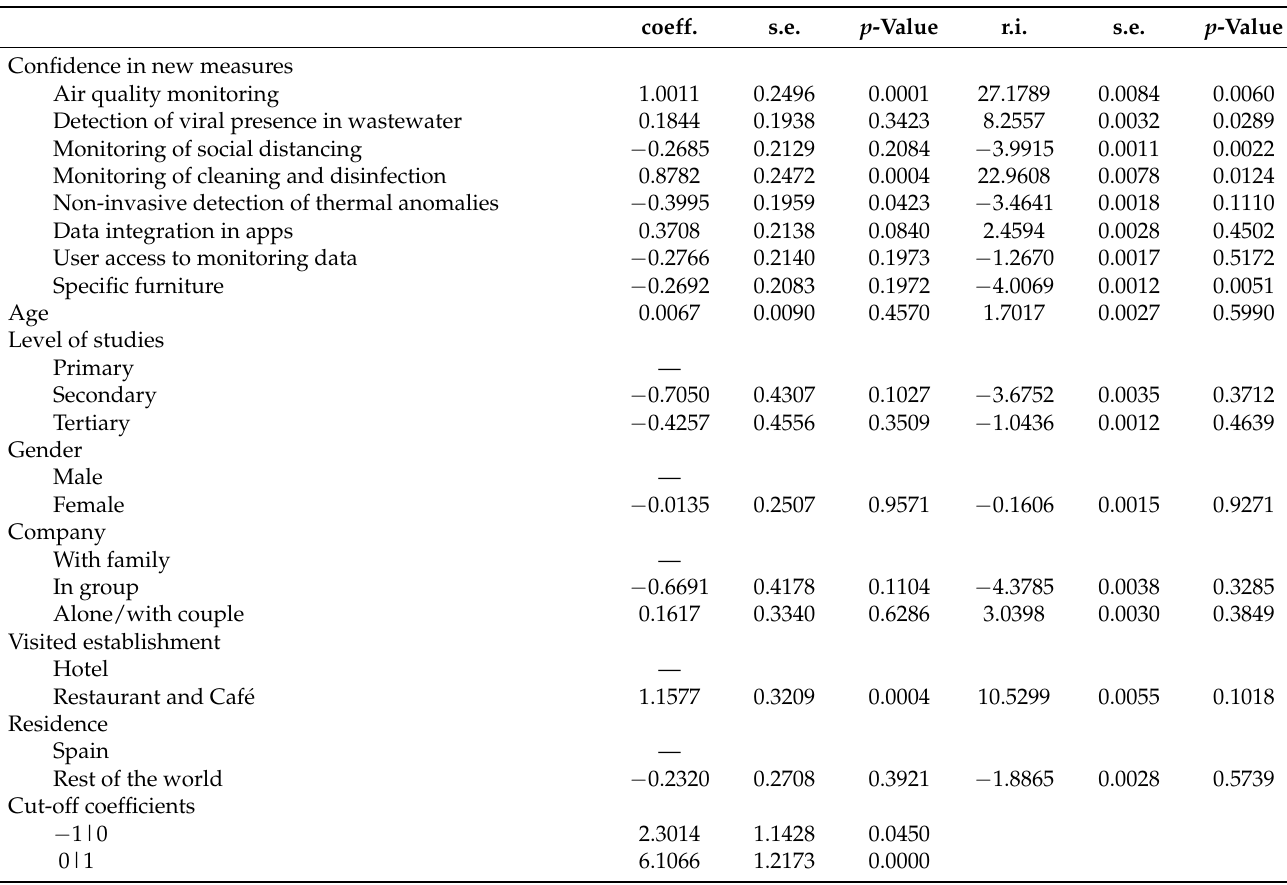
Table 7. Ordinal logit model for changes in consumers’ intention to repeat.